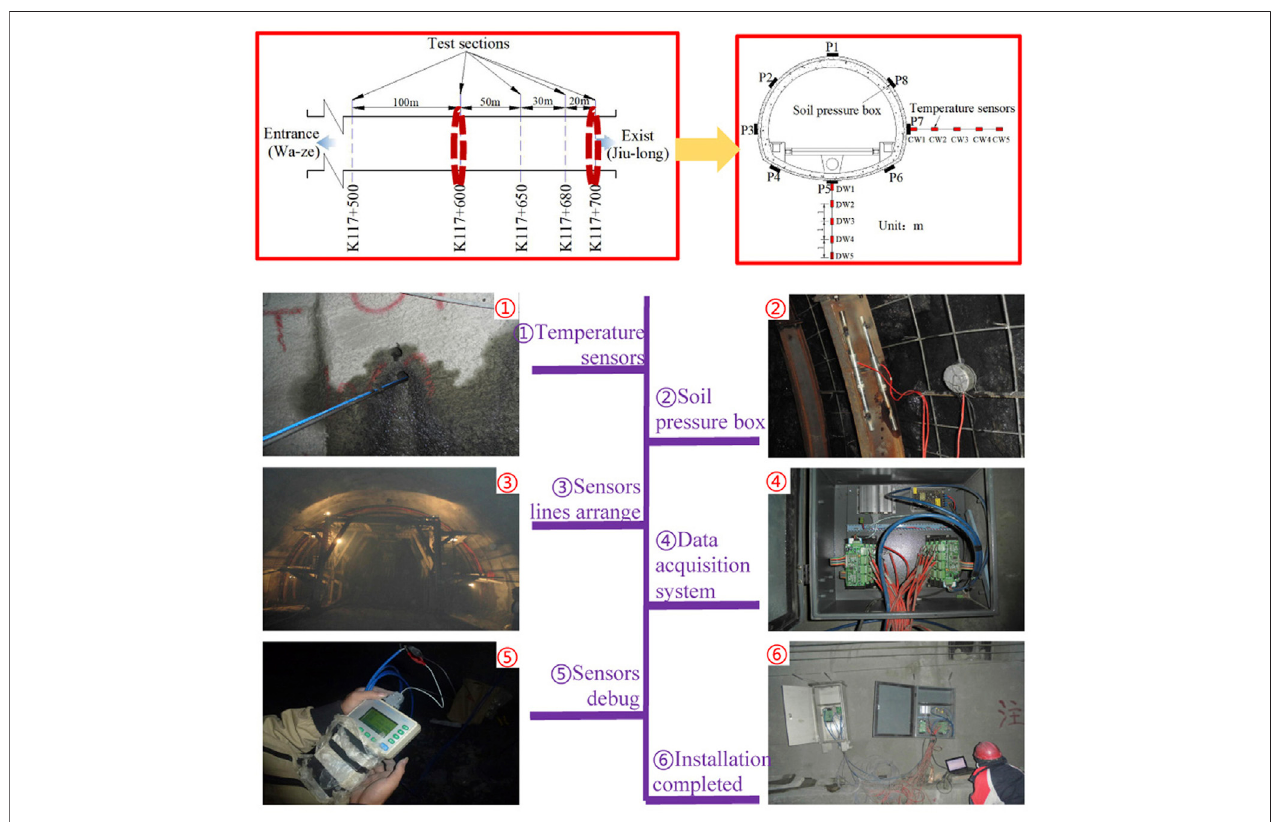
FIGURE 2 | The measured section layout and sensors